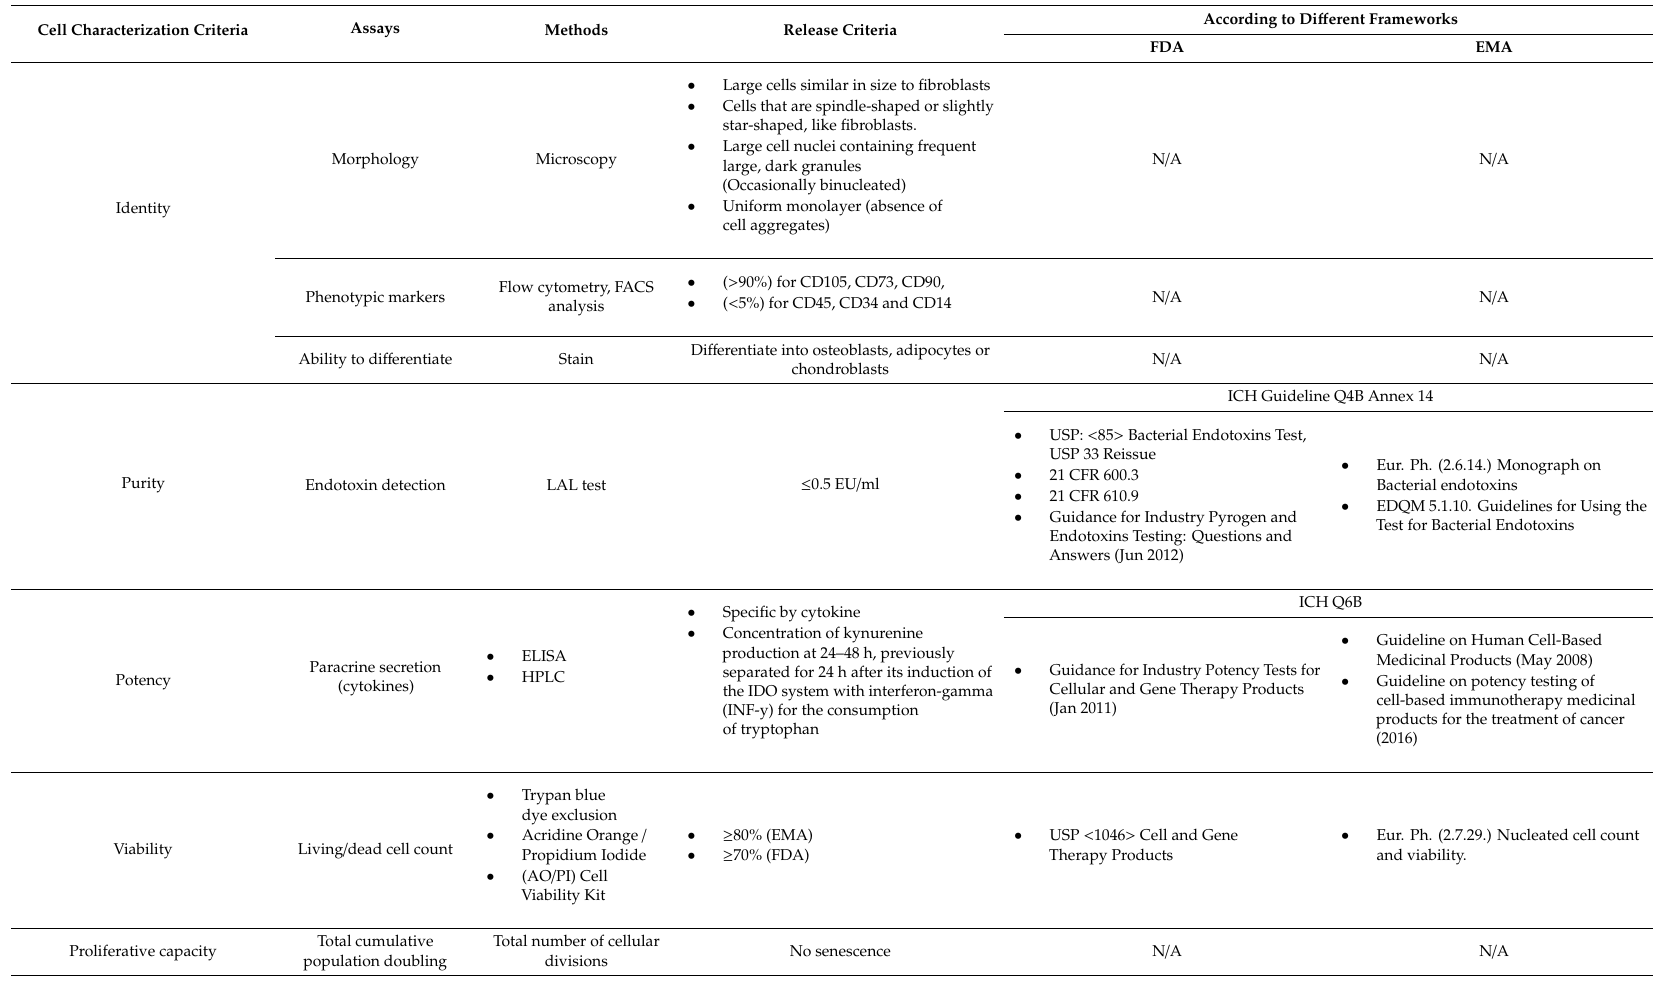
Table 1. Specifications of hMSC-based final products before administration to a patient based on the primary criteria for quality. Cell Characterization